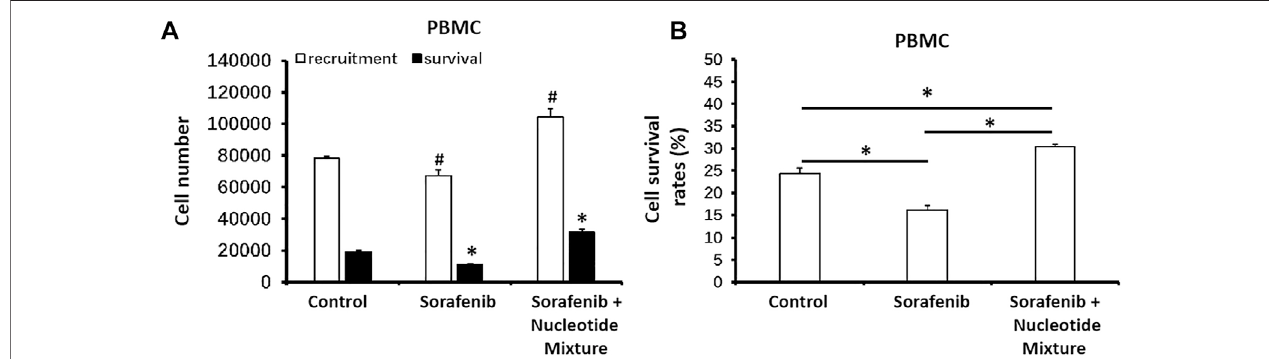
FIGURE 6 | The SNM could promote the recruitment and survival of healthy volunteer-derived peripheral-blood lymphocytes in the subcutaneous tumors formed byMHCC97-H cellsinmice.MHCC97-H cellswereobtainedbyculture.Then, cellswereinoculatedsubcutaneouslyintoSCIDmicetoenableformationoftumor tissue. Simultaneously, peripheral-blood lymphocytes from healthy volunteers were infused back into SCID mice (~1 × 10 7 cells per mouse). Then, mice received sorafenib (1 mg/kg, p.o.) or a combination of sorafenib (1 mg/kg) + SNM (0.2 g/kg). Then, tumor tissue was collected, ground, and fl ow cytometry-sorted to determine the level in each 50 mg of tissue. The number of peripheral-blood lymphocytes recruited (CD45 + fraction) and the number of surviving peripheral-blood lymphocytes (CD45 combined with trypan-blue staining) (A) or survival of cells (B) are shown as histograms. (A) * p < 0.05 compared with control (recruitment of peripheral-blood lymphocytes); (B) # p < 0.05 compared with control (survival of peripheral-blood lymphocytes). * p <